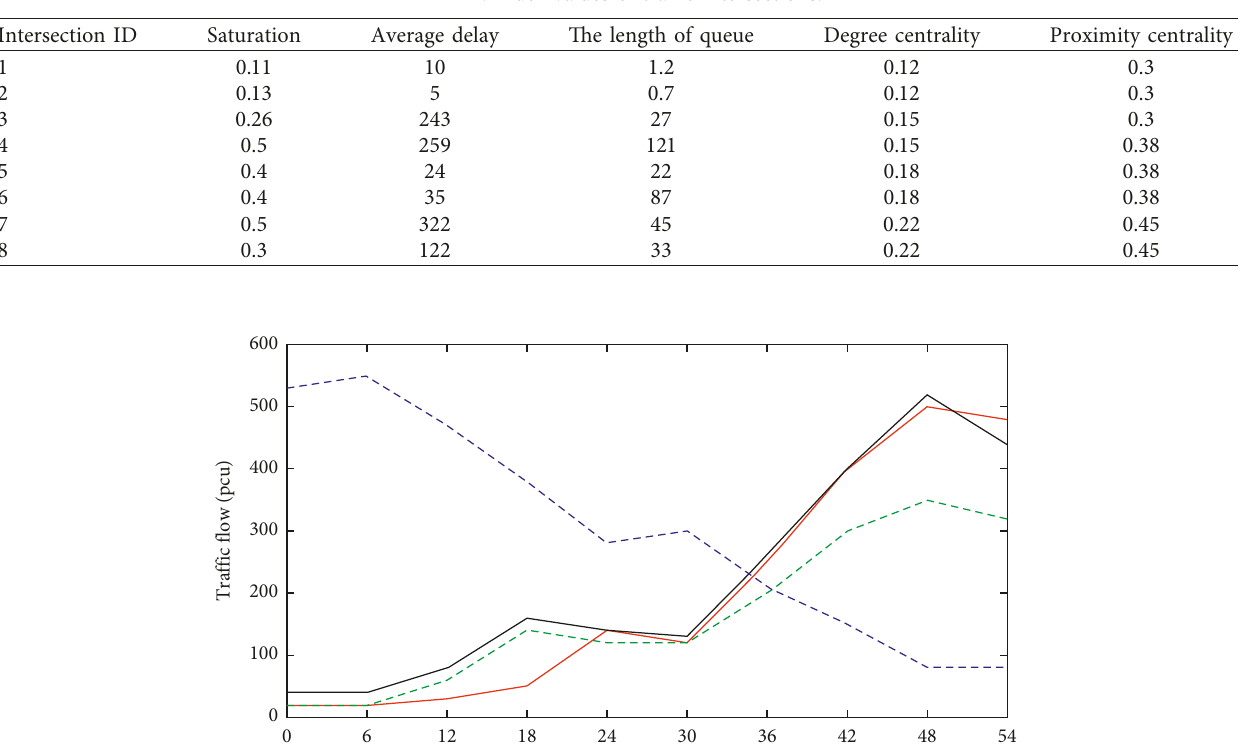
Table 2: Index values of traffic intersections.